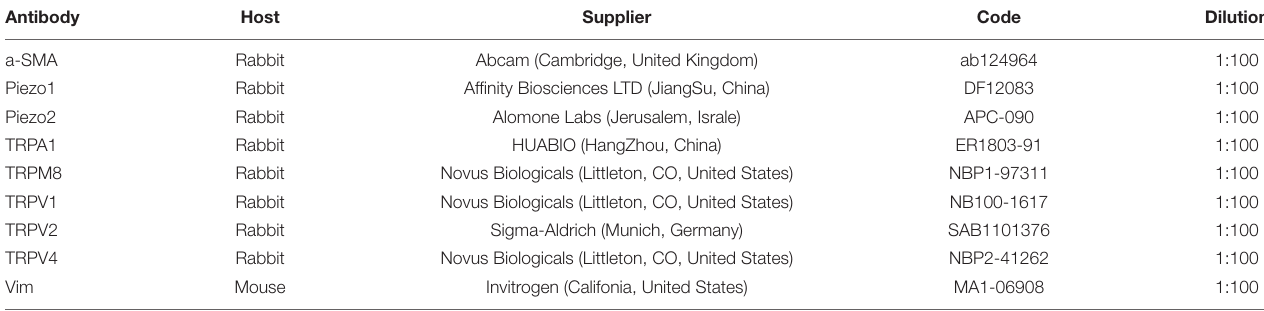
TABLE 2 | Primary antibodies used in immunohistochemistry